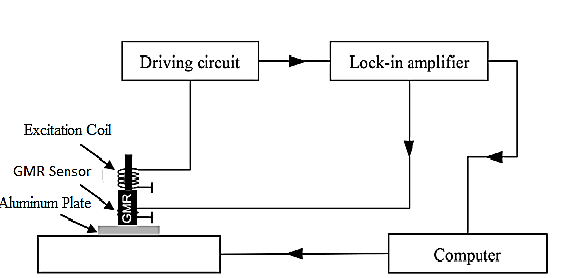
FIGURE 8. Schematic of the experimental setup for the eddy current testing system with giant magnetoresistance probe.